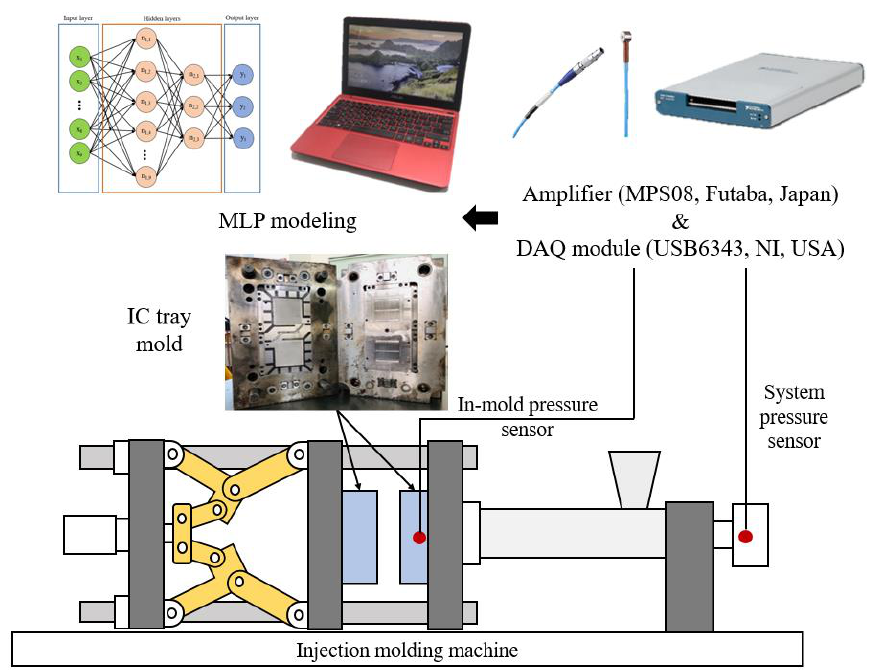
Figure 7. Schematic of the MLP inspection system.